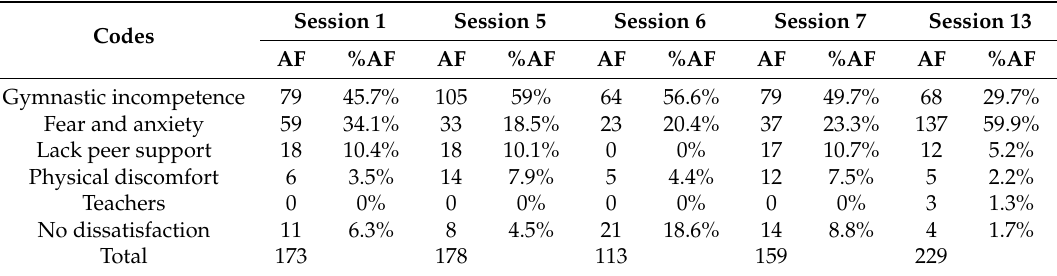
Table 4. Motivations for dissatisfaction in gymnastics learning, by